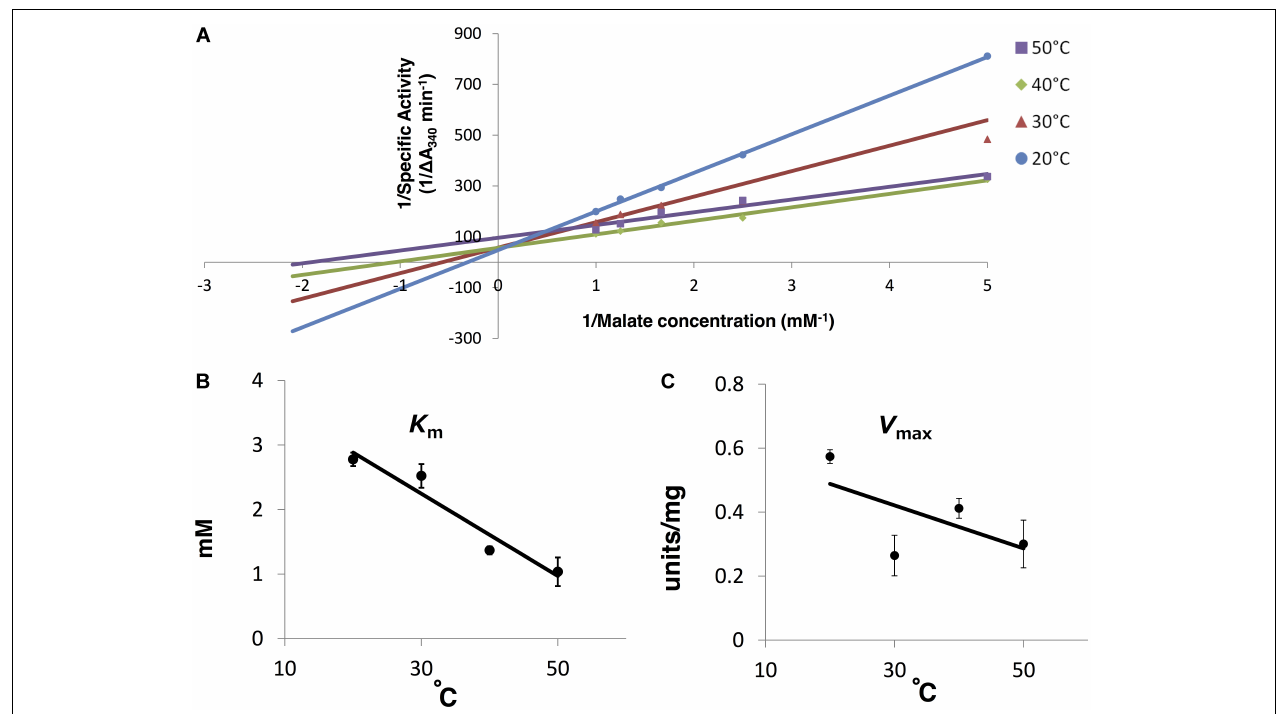
FIGURE 6 | Thermal profiles of Sy MDH in the oxidative reaction in vitro . (A) Lineweaver–Burk plot of the Sy MDH activity in the oxidative reaction at 20–50 ◦ C. Blue, red, green, and purple lines indicate condition at 20, 30, 40, and 50 ◦ C, respectively. The graph shows the mean of three independent experiments. (B) K m (mean ± SD) values for malate were obtained from three independent experiments by varying the temperature (20–50 ◦ C). (C) V max (mean ± SD) (units/mg protein) values for malate were obtained from three independent experiments by varying the temperature (20–50 ◦